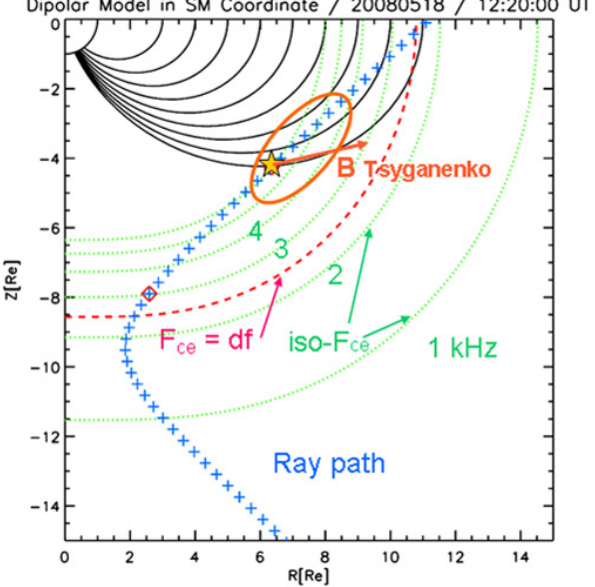
Fig. 9. NTC source position on 18 May 2008, obtained by the 3-D- isoFce approach and displayed in a meridian view of SM coordinate system ( R : distance from dipole axis; Z : distance from magnetic equatorial plane). Cluster tilted pair is represented by a red diamond and the ray path by blue crosses. Curves at constant gyro-frequency (according to magnetic dipole model) are plotted in green for round F ce values and in dashed red for the gyro-frequency value at source (as estimated from NTC signature). The source position in a realis- tic magnetic field model is shown by a star, inside a global region sketched by an oval (see text), and the orange arrow points to the modelled magnetic field vector B at